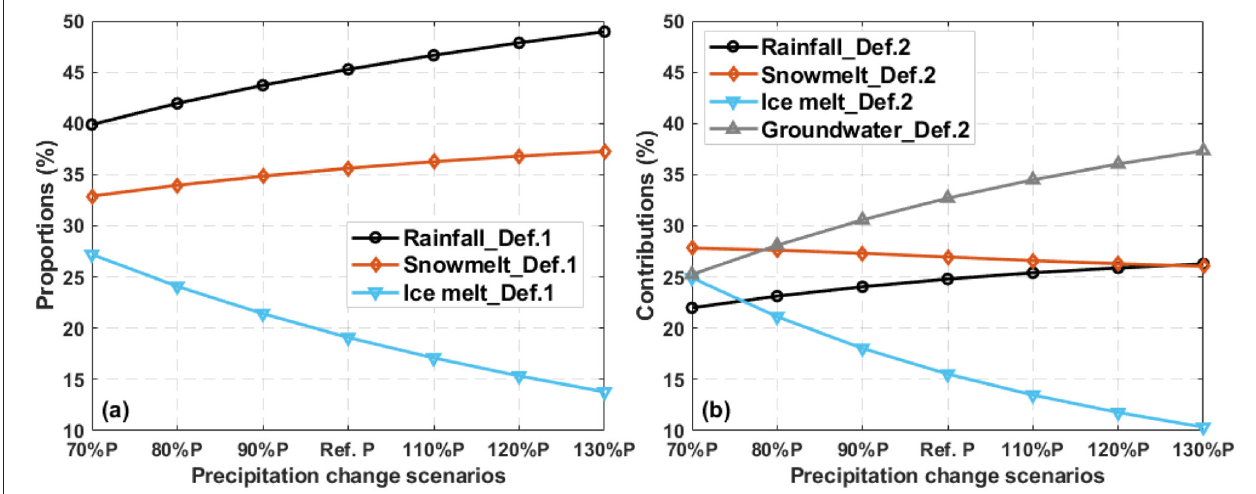
FIGURE 8 | Changes of mean annual proportions of water inputs and contributions of runoff components, in response to precipitation changes. “Def. 1” is for the definition of water input, and “Def. 2” refers to the definition of runoff components based on flow pathway. Dots indicate mean values during the 20-year modeling